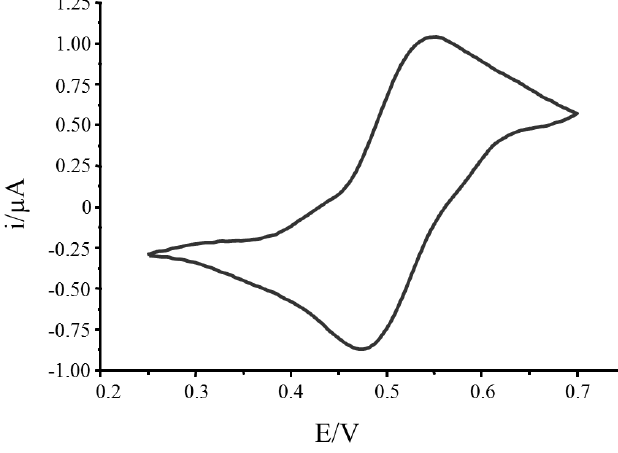
Figure 3. Cyclic voltammogram of Super AquaBlue TM showing both oxidation (anodic) and reduction (cathodic) peaks of ABTS on glassy carbon electrode (vs. Ag/AgCl) with 0.4 V applied potential in Super AquaBlue TM .